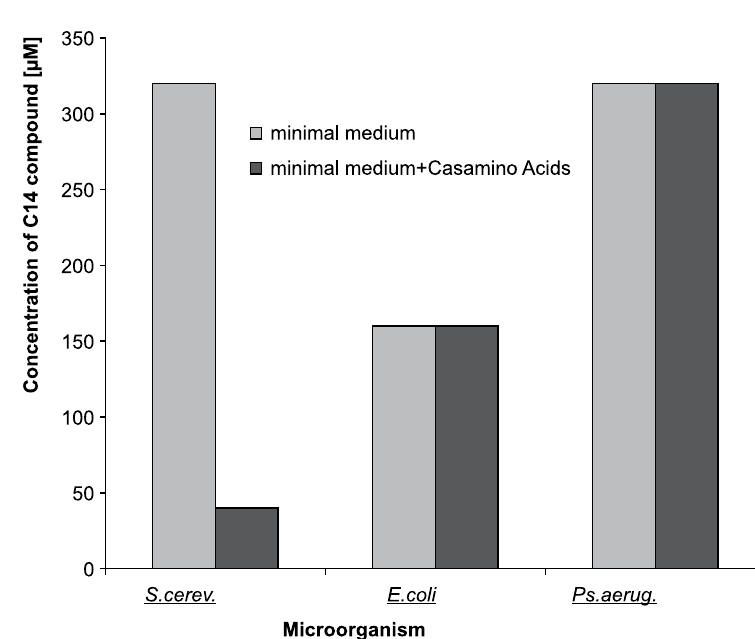
Fig. 3. Effect of supersensitivity of E.coli, P.aeruginosa, S.cerevisiae and to C14